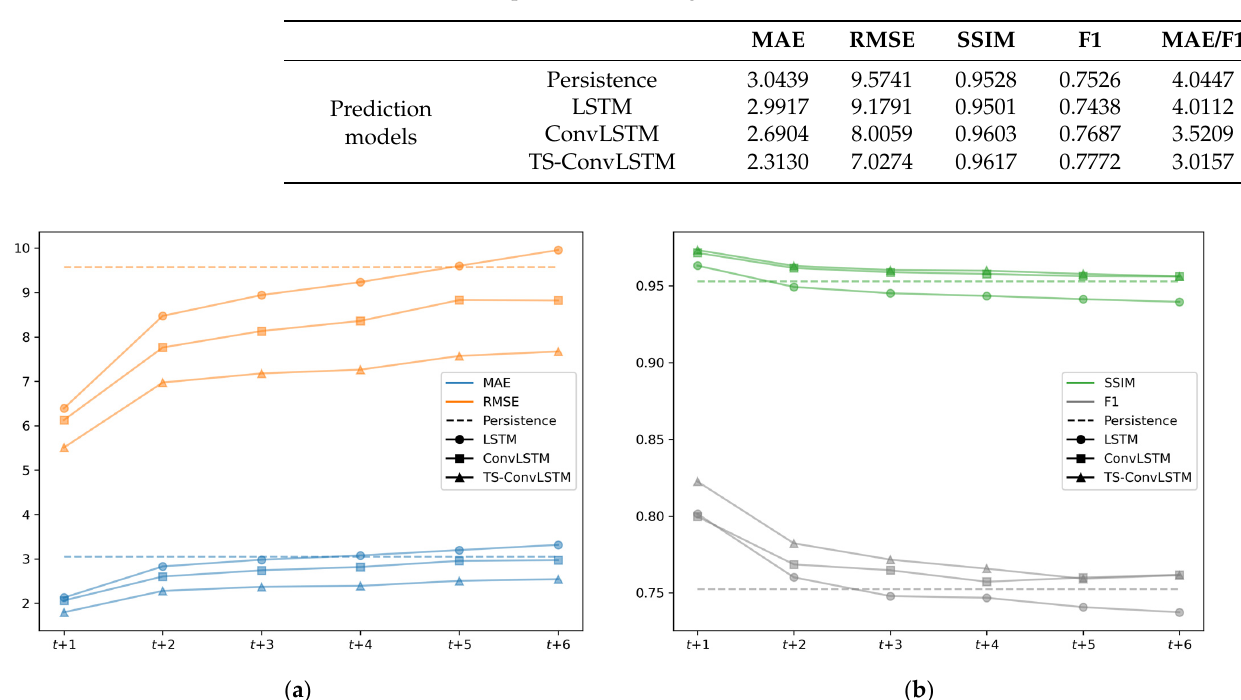
Figure 4. Statistical accuracy comparisons of the prediction models, including persistence, long- and short-term memory (LSTM), convoluted LSTM (ConvLSTM), and Two-Stream ConvLSTM (TS-ConvLSTM) based on the lead-time. ( a ) MAE (blue lines) and RMSE (orange lines); ( b ) SSIM (green lines) and F1 (gray lines).